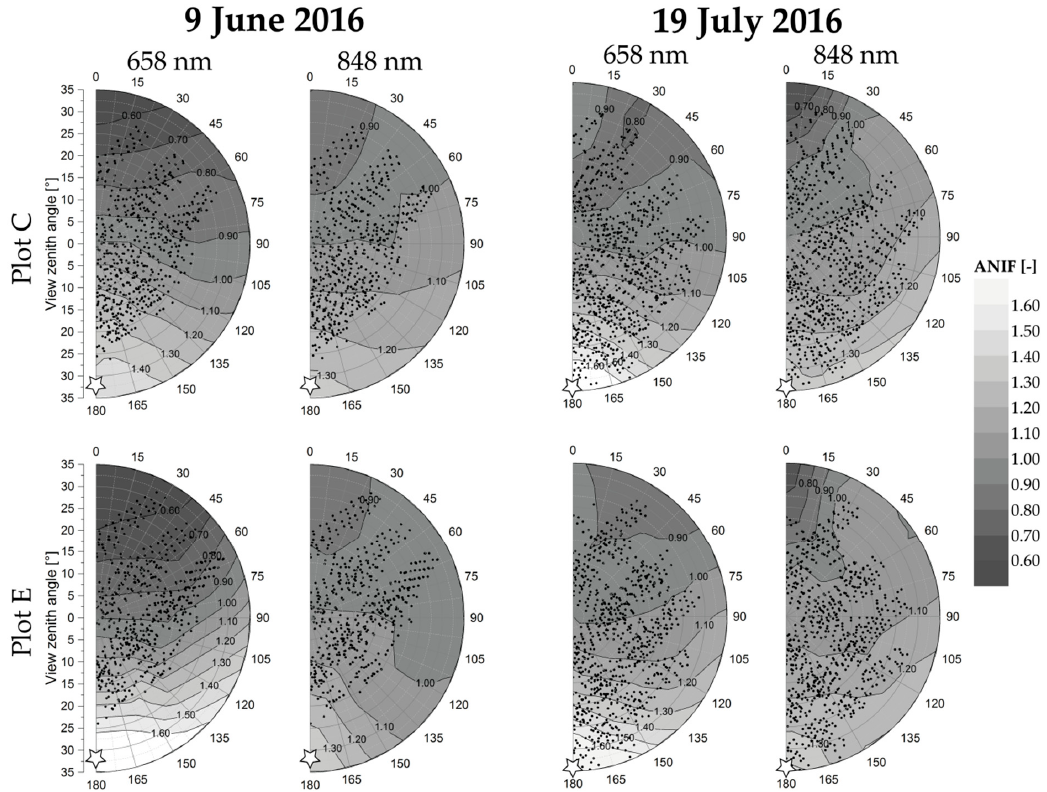
Figure 8. The reflectance anisotropy derived from of all pixels within experimental Plot C ( top ) and Plot E ( bottom ) shown as linearly inter- and extrapolated polar graphs at 658 nm and 848 nm, collected on 9 June 2016 ( left ) and 19 July 2016 ( right ), respectively. The white stars indicate the position of the sun during data collection and the black dots indicate the measurement positions.